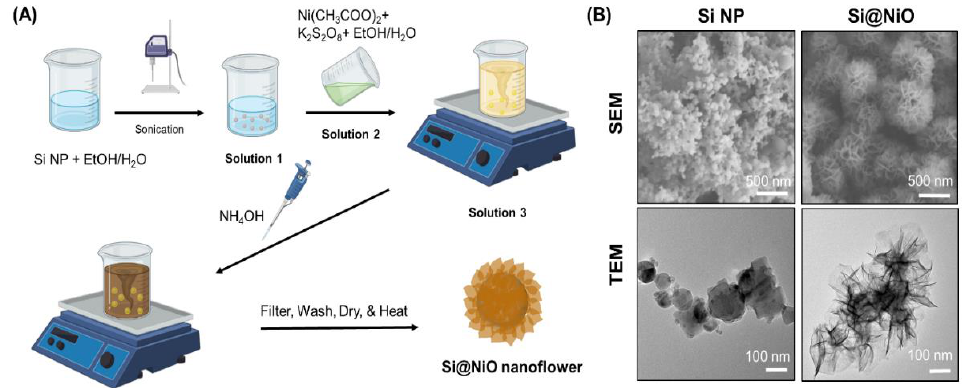
Figure 1. Synthesis and characterization of Si@NiO nanoflowers. ( A ) Schematic representation of the synthesis of Si@NiO nanoflowers. ( B ) SEM and TEM images of Si NPs and Si@NiO nanoflowers.